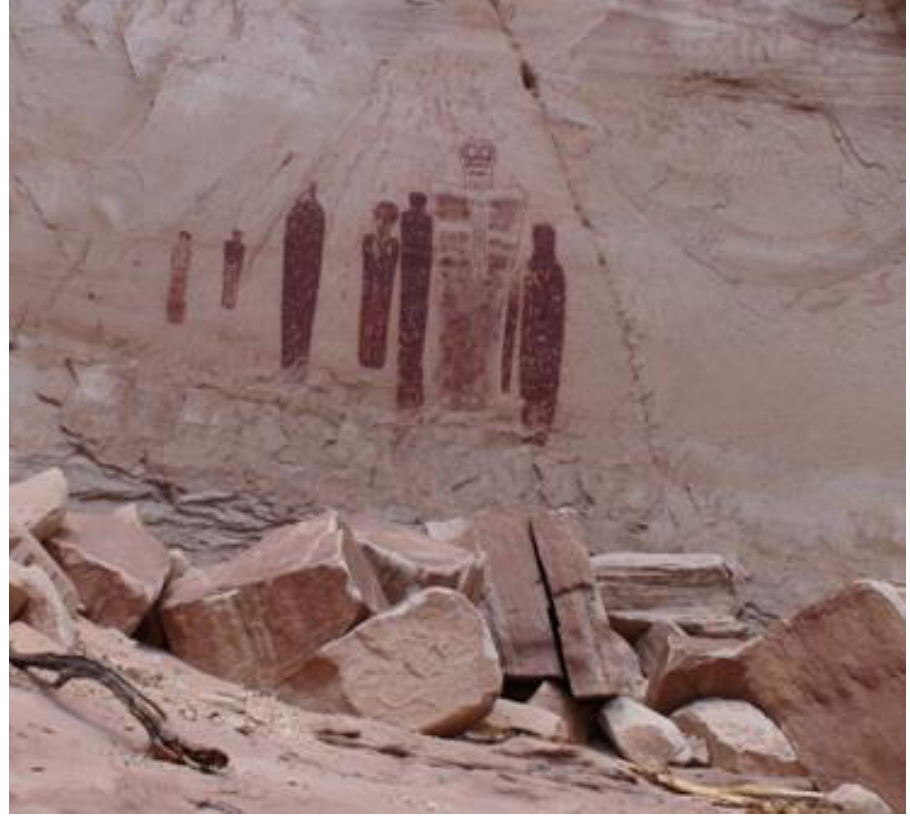
Figure 20. “Looming” Barrier Canyon performative figures, Utah,